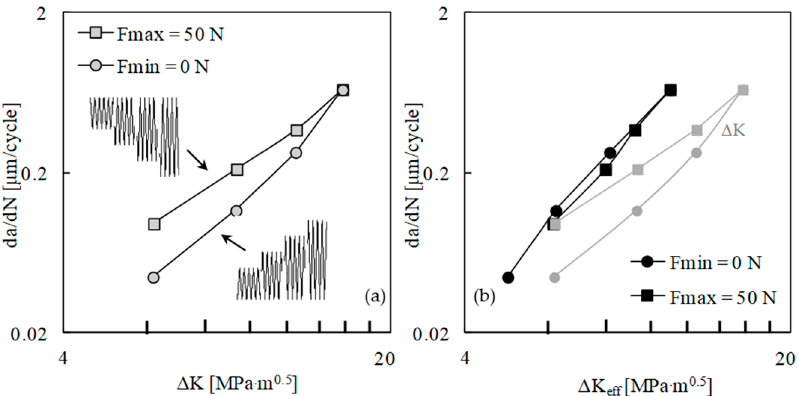
Figure 2. E ff ect of the constant amplitude loading limits on the fatigue crack growth (FCG) rate: Figure 2. Effect of the constant amplitude loading limits on the fatigue crack growth ( FCG) rate: ( a ) ( a ) da / dN versus ∆ K . ( b ) da / dN versus ∆ K e ff . da/dN versus Δ K . ( b ) da/dN versus Δ K eff .